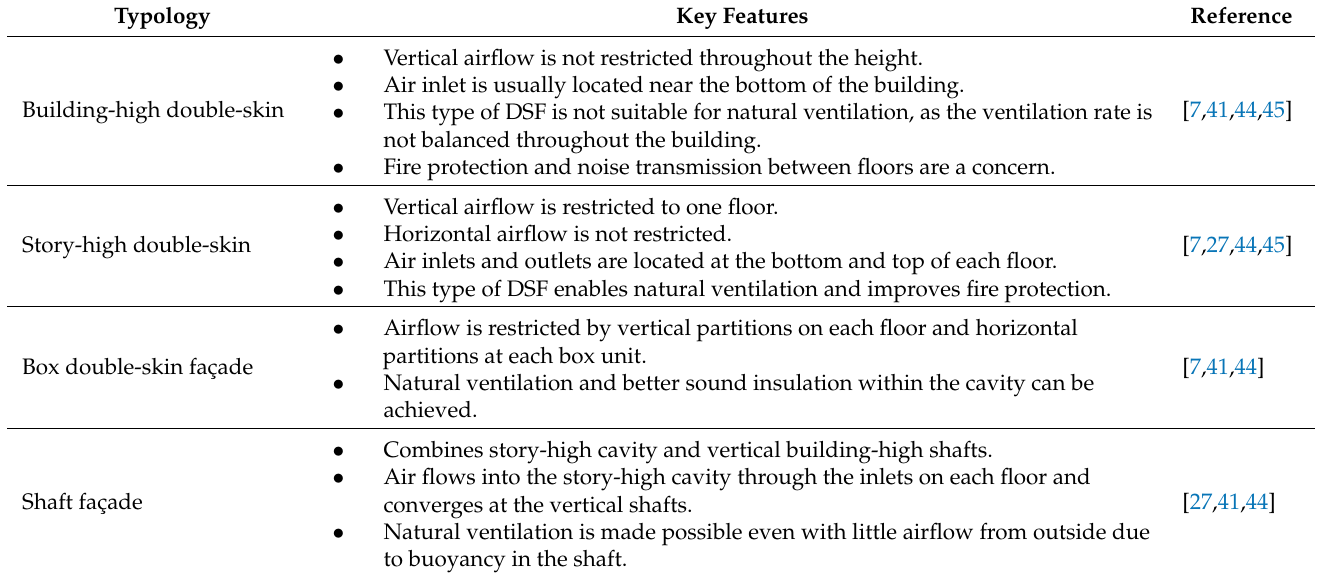
Table 2. DSF Cavity Typology